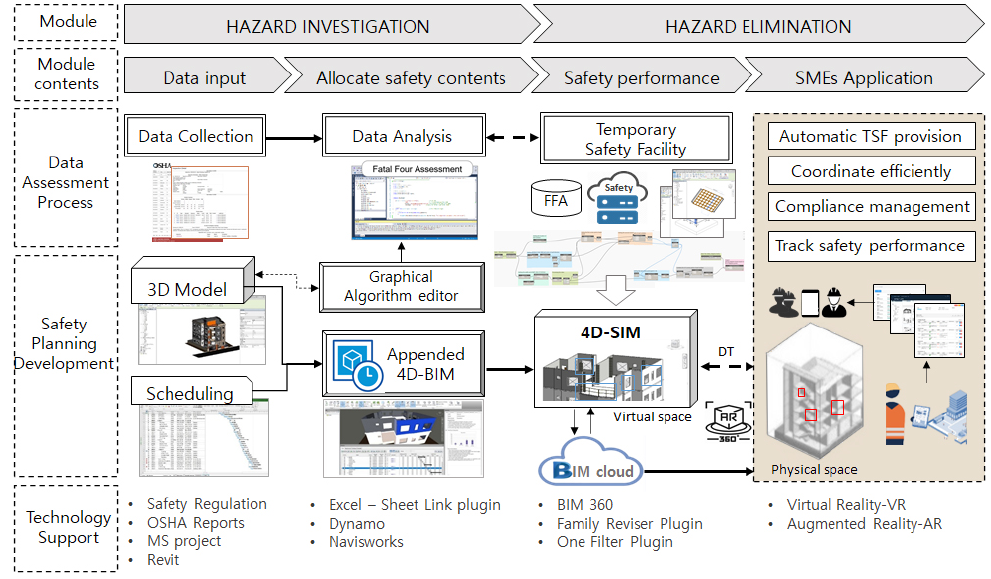
Figure 2. Proposed framework for workspace planning for temporary safety facilities (TSFs) (WPT)